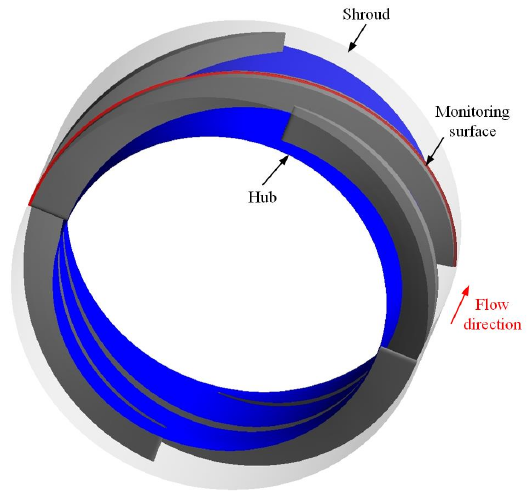
Figure 5. Schematic diagram of the monitoring surface.